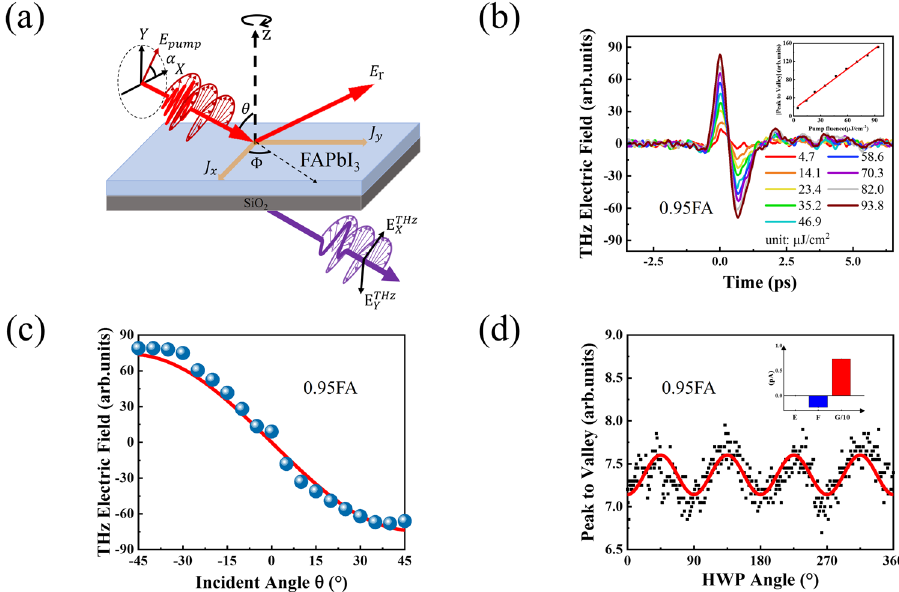
fl uence at incident angle of 45°; Inset in ( b ) are pump fl uence dependent peak-to- valley value ofTHz electric fi eld amplitudewith480nm laserexcitation; c Incident angle θ dependentpeak-to-valleyvalueofTHzelectric fi eldamplitudewith480nm laser excitation, the fi tted red line through the data points is based on the second term of Eq. (1); d THz electric fi eld amplitude dependent on the polarization direction of pump light in 0.95FA, inset are the fi tting